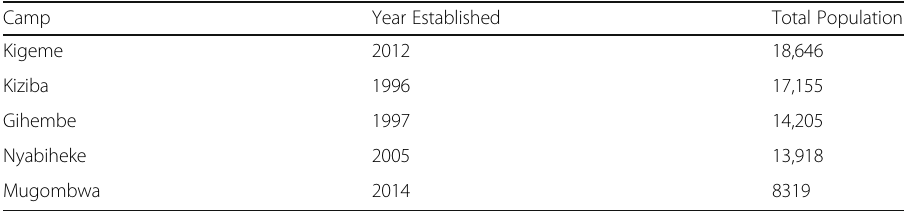
Table 1 Breakdown of Congolese refugee camps in Rwanda Camp